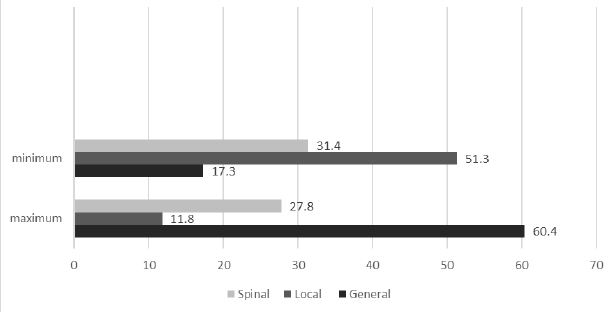
Figure 3: Aerosol generation in a specific anesthesia Table 2 : Intraoperative outcome